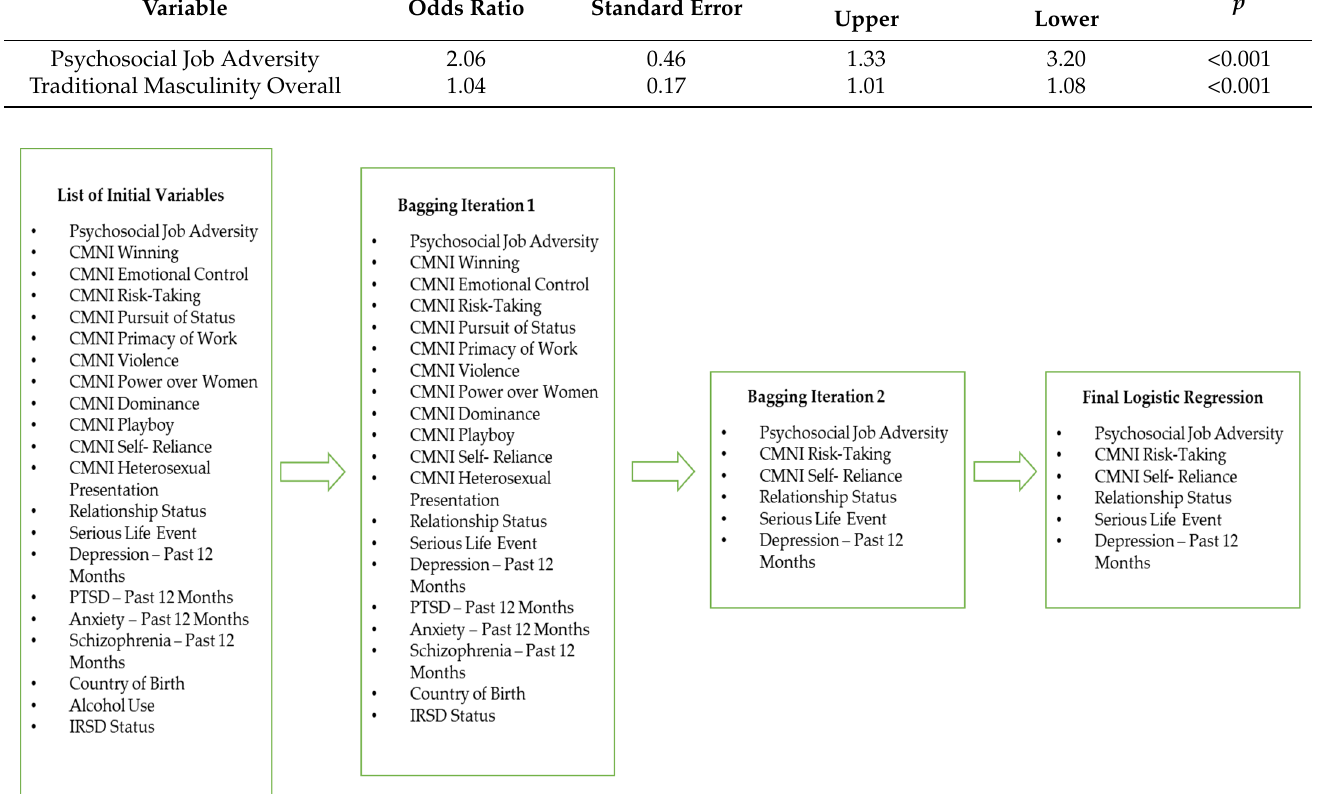
Figure 2. Logistic Regression Variable Selection Procedure.